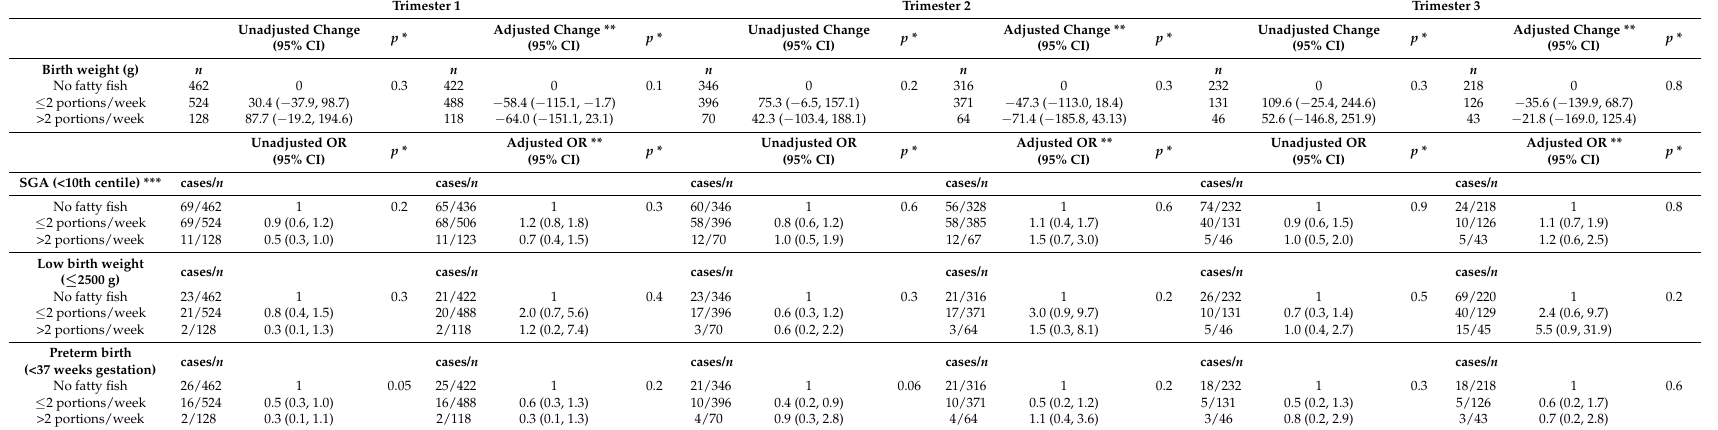
Table 4. The relationship between maternal fatty fish intake during pregnancy and size at birth & preterm